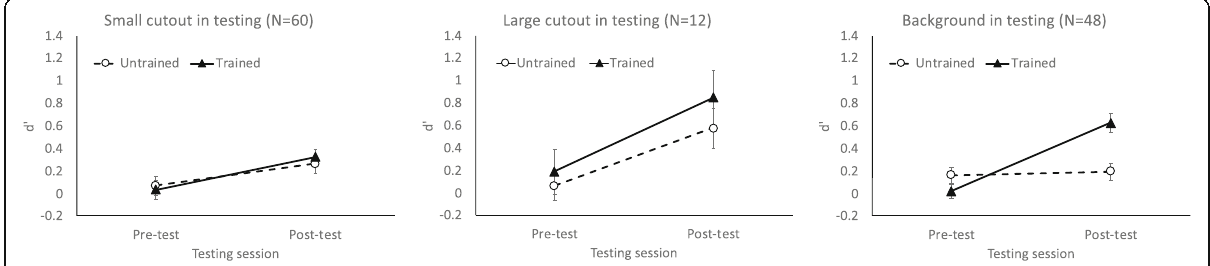
Fig. 6 Value of d ’ from the testing sessions involving parts of an image. Left: the small cutout with a side length equal to the tumor diameter. Middle: the large cutout with a side length twice the tumor diameter. Right: the background region after the tumor was cut out. Error bars show +/ − 1 S.E. of the